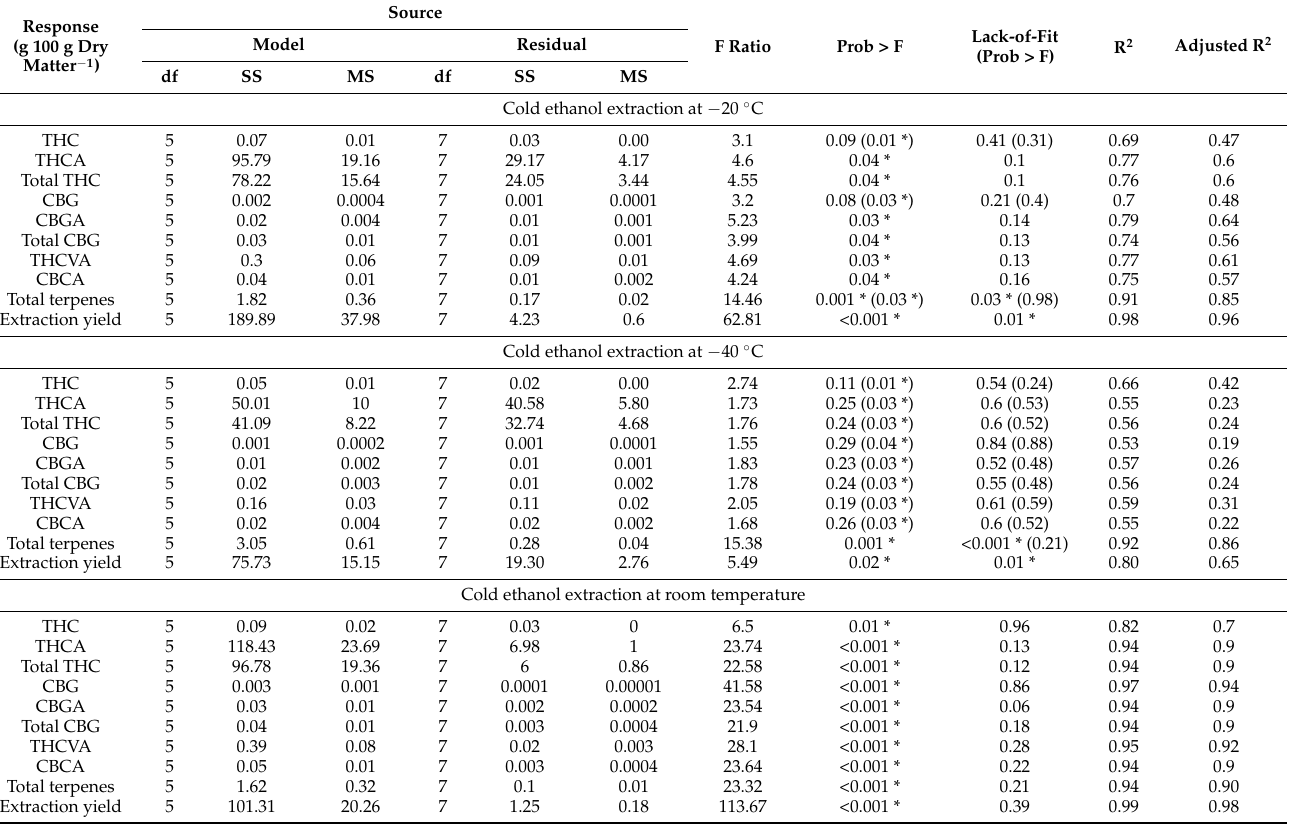
Table 4. Analysis of variance (ANOVA) analyses of responses for cold ethanol extraction at different